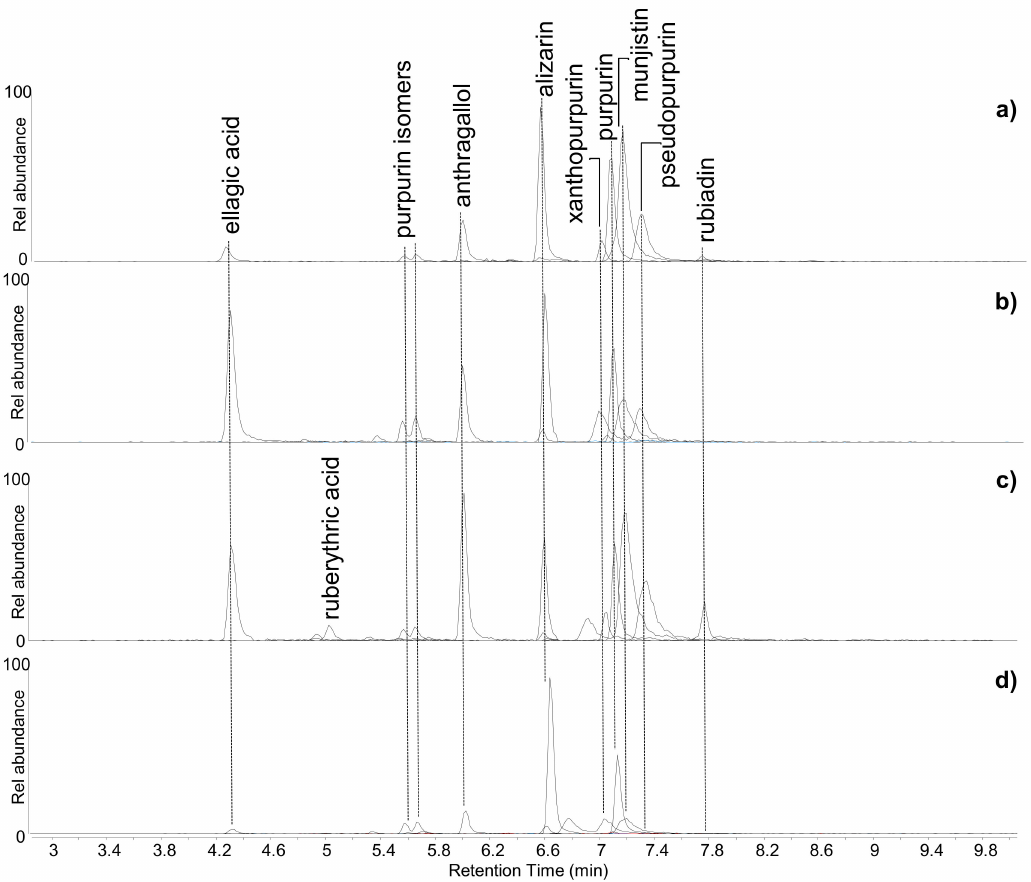
Figure 3. Extract ion chromatograms of the molecular components of madder ( Rubia spp.)—alizarin and xanthopurpurin [M-H] − = 239.035 m / z ; rubiadin [M-H] − = 253.051 m / z ; purpurin and anthragallol [M-H] − = 255.031 m / z ; munjistin [M-H] − = 283.025 m / z ; pseudopurpurin [M-H] − = 299.020 m / z; ruberythric acid [M-H] − = 563.1406 m / z —and tannin-related compound—ellagic acid [M-H] − = 300.999 m / z —obtained by HPLC-ESI-Q-ToF analysis (negative mode) of ( a ) ME2, ( b ) BM2, ( c ) BM4, and ( d )